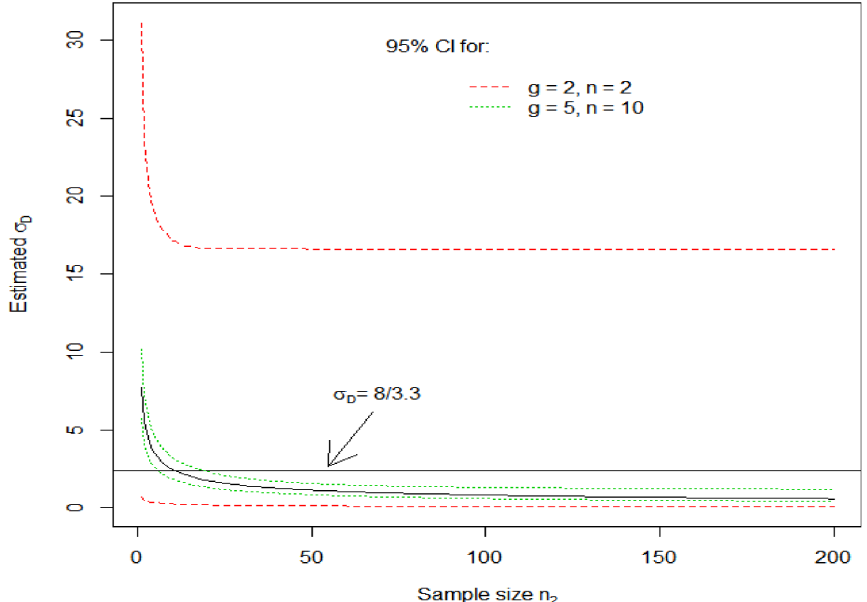
Fig. 3. The estimate of s D versus sample size n 2 for two values of n 1 (case A: g =2, n = 2 so n 1 =4, or case B: g =5, n = 10 so n 1